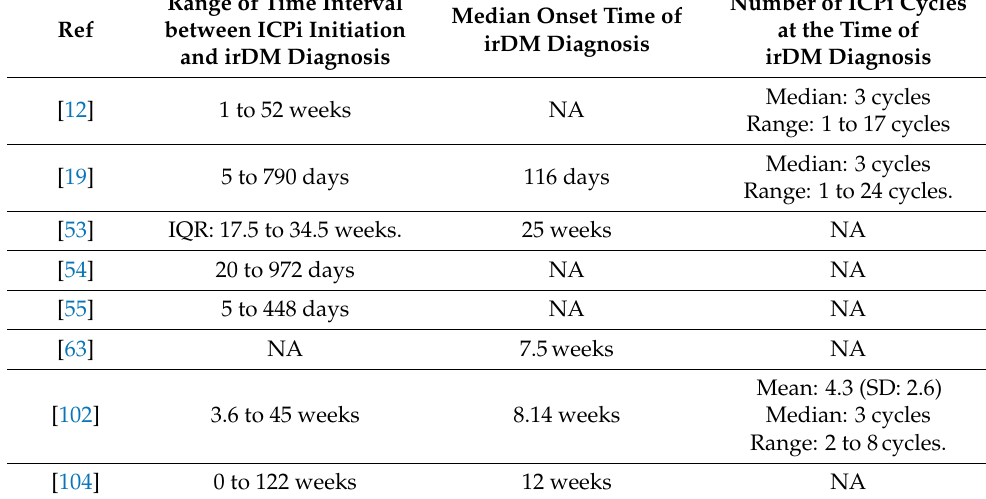
Table 2. Representative data regarding the time of onset of irDM and the number of ICPi cycles at the time of irDM diagnosis. Number of ICPi Cycles Range of Time Interval Median Onset Time of at the Time Ref between ICPi Initiation irDM Diagnosis and irDM Diagnosis